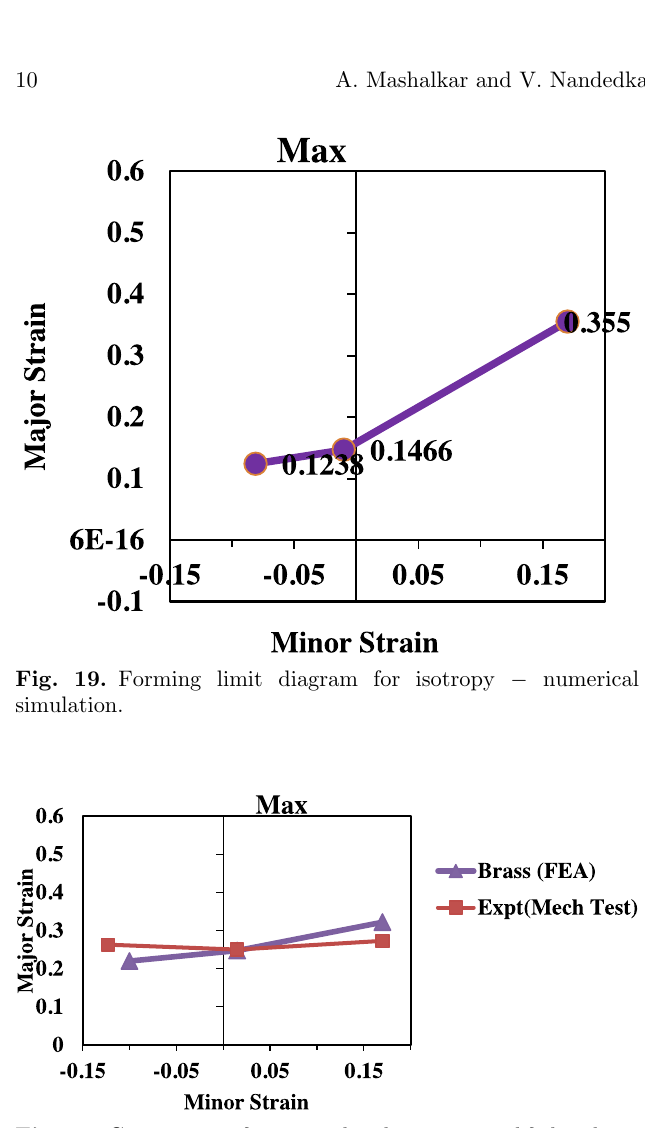
Fig. 20. Comparison of numerical and experimental failure limit curves for brass orientation.